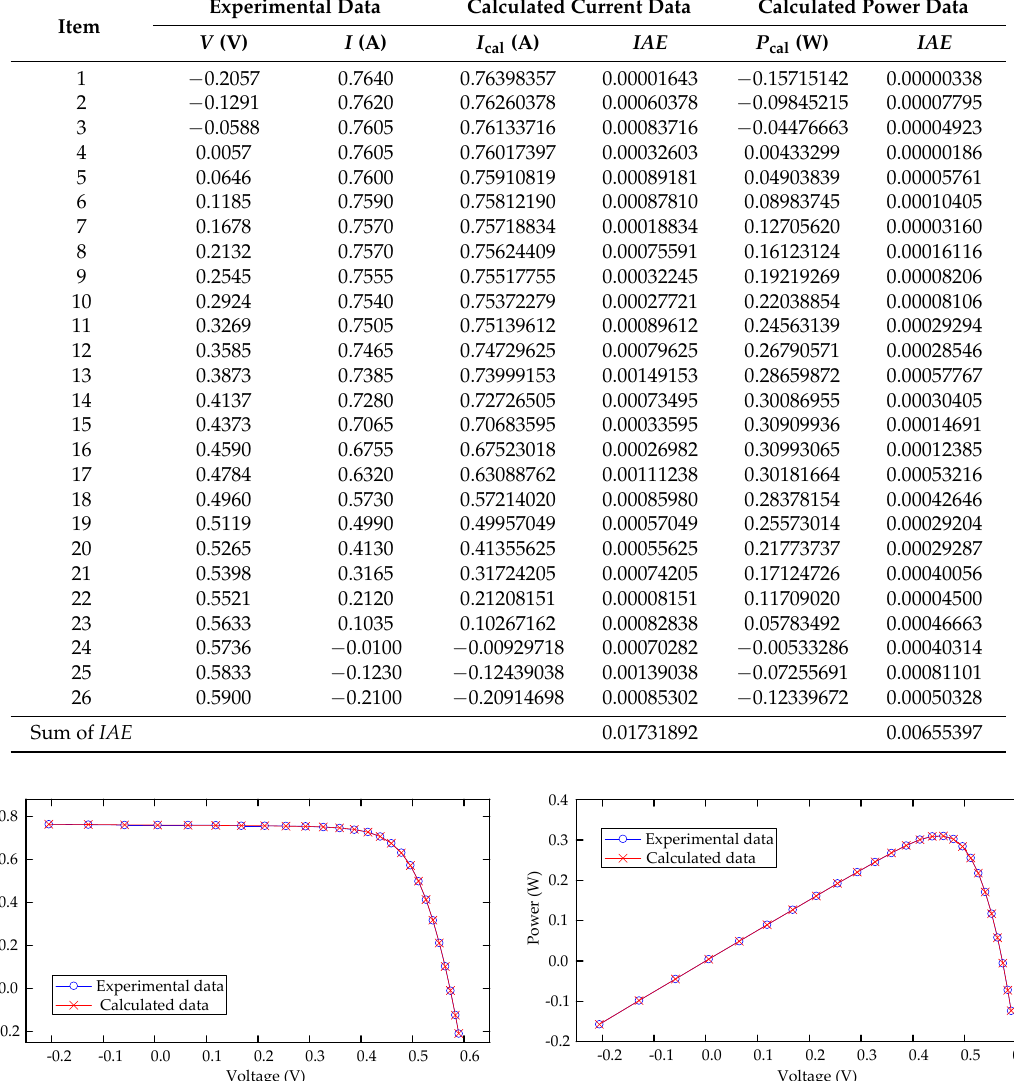
Table 6. The calculated results of the proposed ImCSA for the DDM of RTC France silicon solar cell.